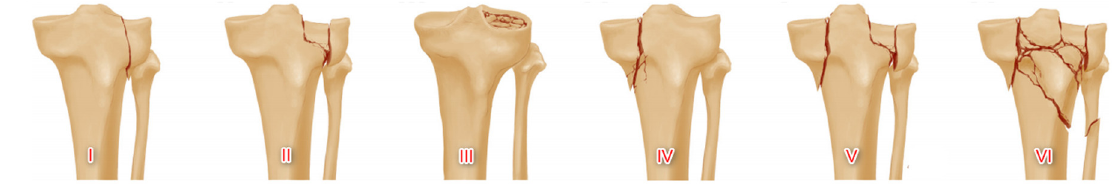
Figure 1. Schatzker classification system of tibial plateau fracture types—from [1].